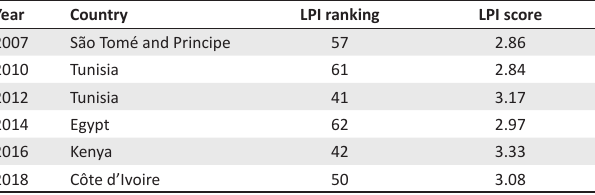
FIGURE 1: World Bank logistics performance ranking and score for South Africa for the period TABLE 1: African countries that are ranked immediately behind South Africa.